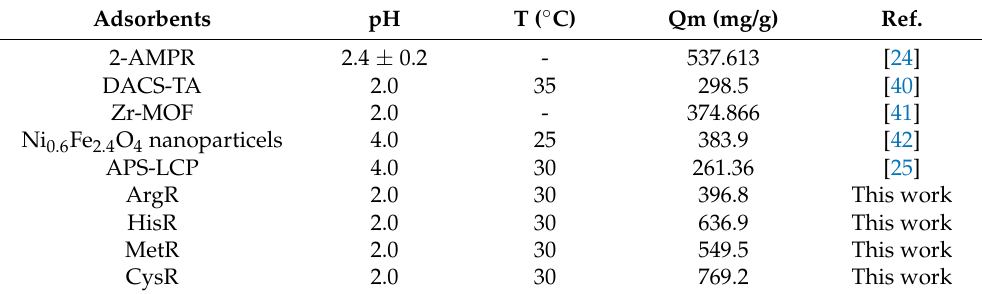
Table 3. Comparison of adsorption capacity of amino acid adsorbents with other available adsorbents.